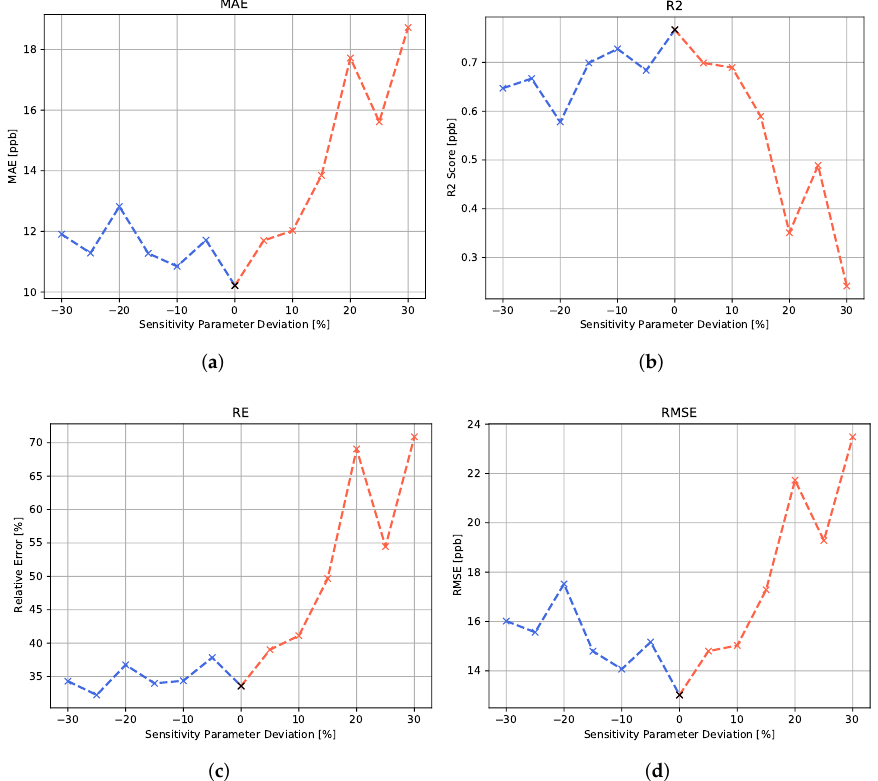
( d ) Figure 7. Error metric plots for the MLP algorithm with respect to the different variations in sensitivity parameter. ( a ) Mean absolute error, ( b ) R 2 score, ( c ) relative error and ( d ) root mean square